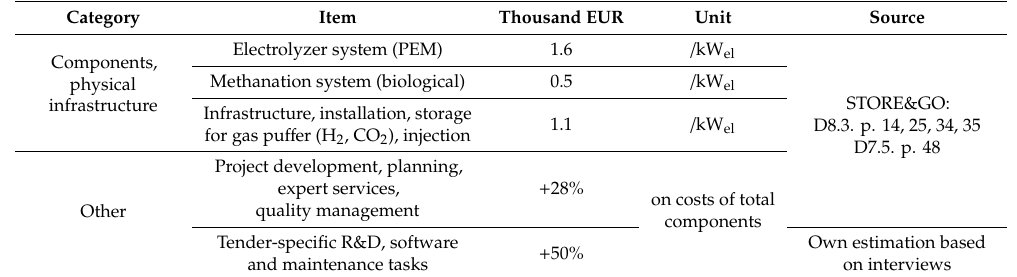
Table A1. Base case for CAPEX calculation at a single WWTP.